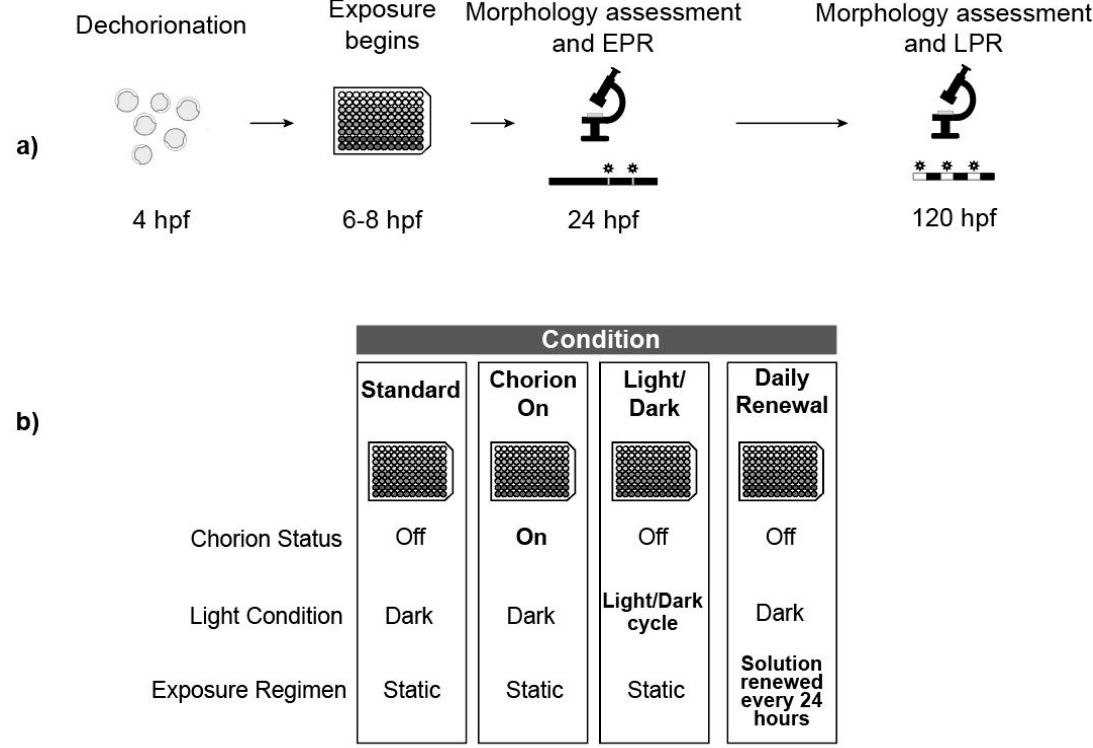
Figure 1. Experimental Design. ( a ) Overview of the Tanguay laboratory’s standard exposure regimen (hpf = hours post fertilization); ( b ) Overview of treatments highlighting exposure conditions that vary from the standard regimen.